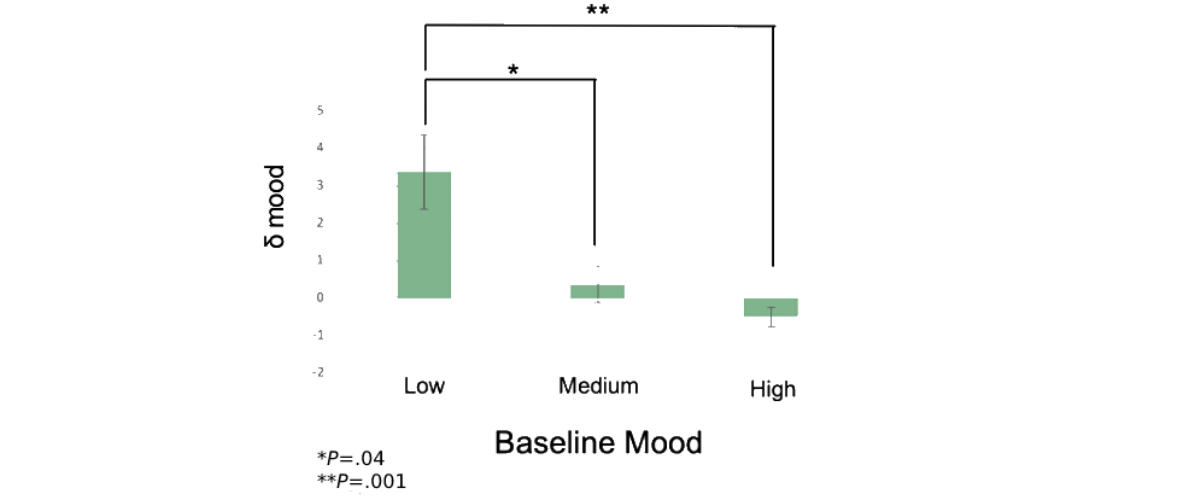
Figure 2. Change in mood from week 1 to week 4 of the intervention ( δ ) for participants varied significantly across mood tiers [ H (2)=14.85; P <.001]. Pairwise comparisons revealed significant differences between low and medium mood tiers ( P =.04) and between low and high mood tiers ( P =.001). * P =.04, ** P